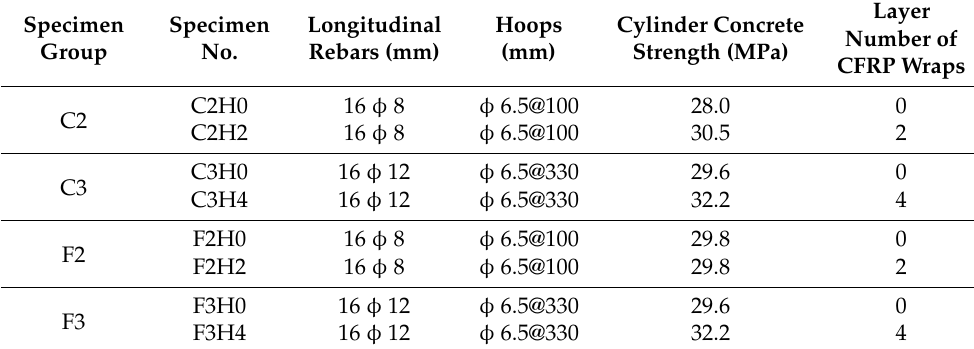
Figure 1. Numerical modeling of a typical RC fixed-hinged column strengthened with CFRP: ( a ) schematic diagram of impact test setup [21]; ( b ) FE model (Note: Units are in mm). Table 1. Parameters of RC column specimens [21,23,33].